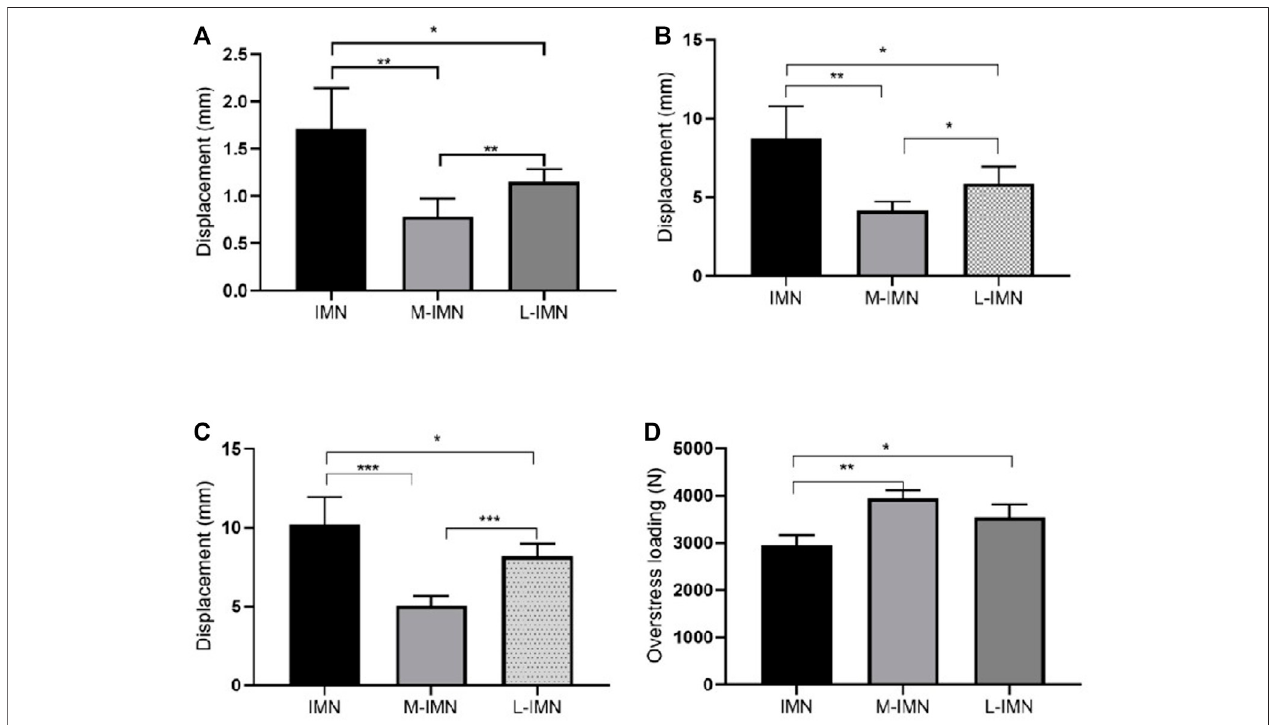
FIGURE 3 | Biomechanical performance in different models. The maximum displacement of IMN, M-IMN, and L-IMN group under axial compression (A) , medial side (B) , and lateral side (C) bending stress, respectively (D) The maximum loading of failure was in three groups. * < 0.05; ** < 0.01; *** < 0.001.